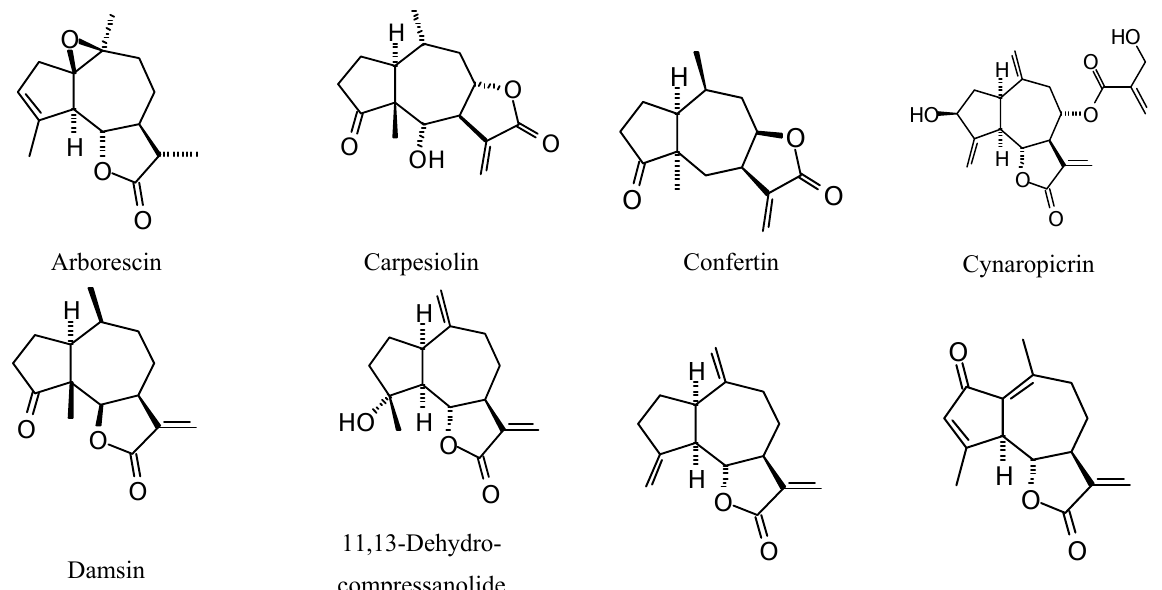
Figure 3. Guaianolide sesquiterpenoids examined in this